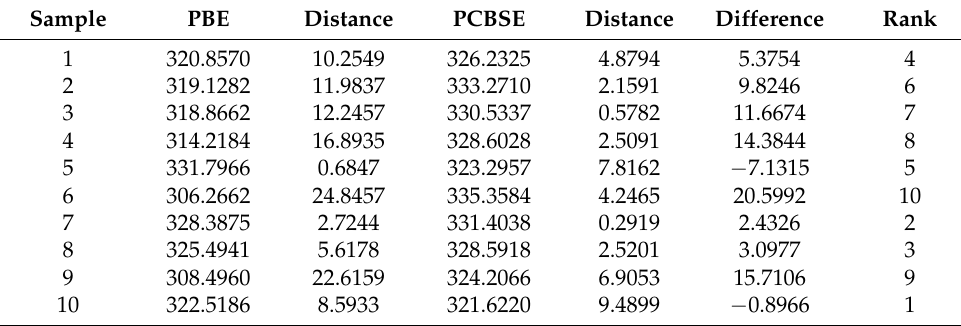
Table 6. Wilcoxon Signed Rank Test.